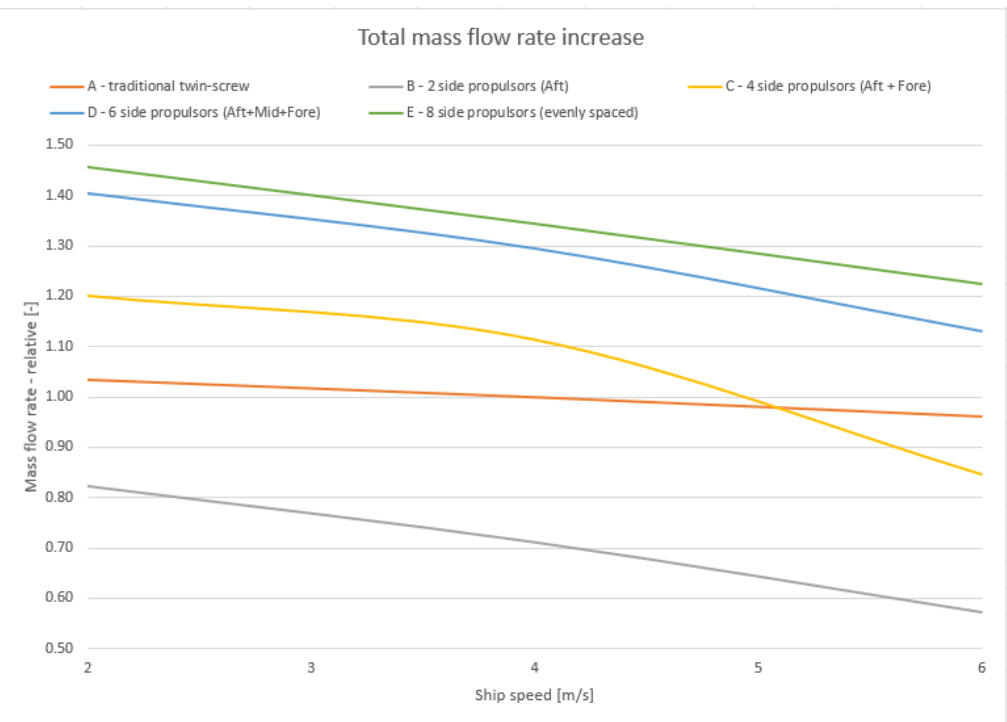
Figure 5. Dynamic pressure at the propulsors’ center plane (Layout E, deep water). Source: Authors.